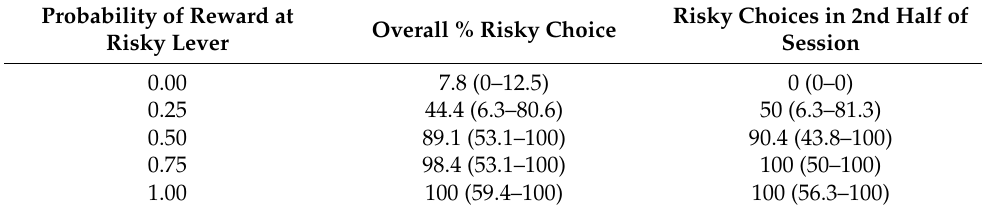
Figure 3. Risk preference at varying reward probabilities on the risky lever in the first baseline week. ( a ) Preference in the completed choice trials from the entire session; ( b ) Preference in the completed choice trials from the second half of the session. Individual data in grey, median values in black. Compared to the indifference point (risky lever rewarded with four pellets in 25% of the trials), rats preferred the risky lever less when it was never rewarded, and more when it was rewarded in 50–100% of the trials (statistical details provided in the text). Table 2. Median (minimum–maximum) risk preference at varying reward probabilities.